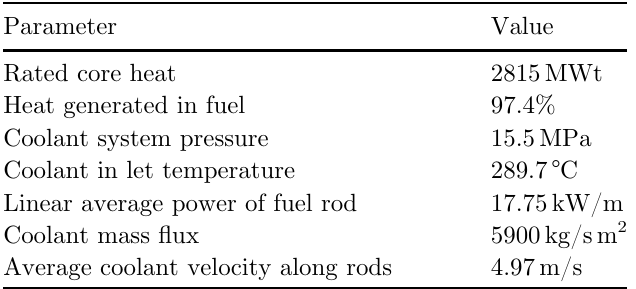
Table 2. Reactor thermal hydraulics parameters. Table 3. Fuel rod data for fuel performance code startup for Zy-4 and SS